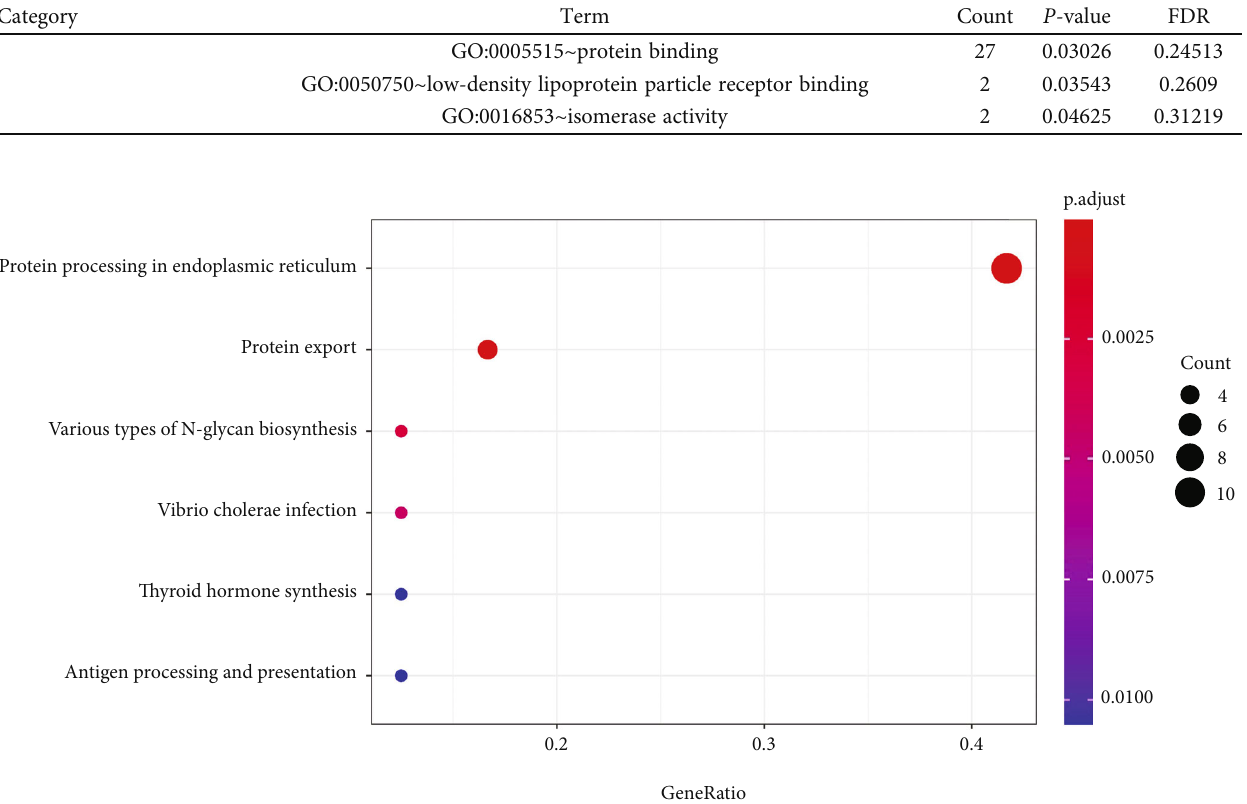
Figure 10: KEGG bubble plot of PDIA3 di ff erentially co-expressed top 50